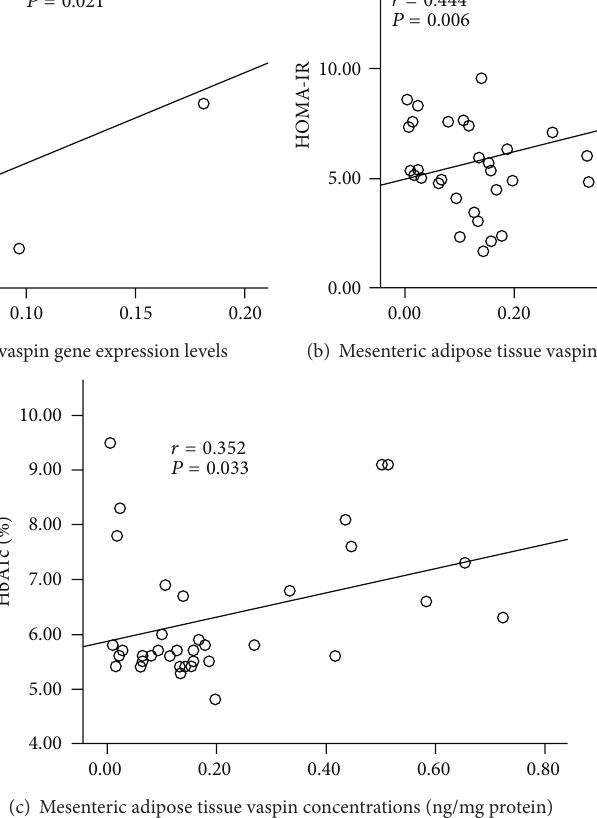
Figure 3: Correlation between tissue vaspin gene or protein expression and blood insulin resistance biomarkers.